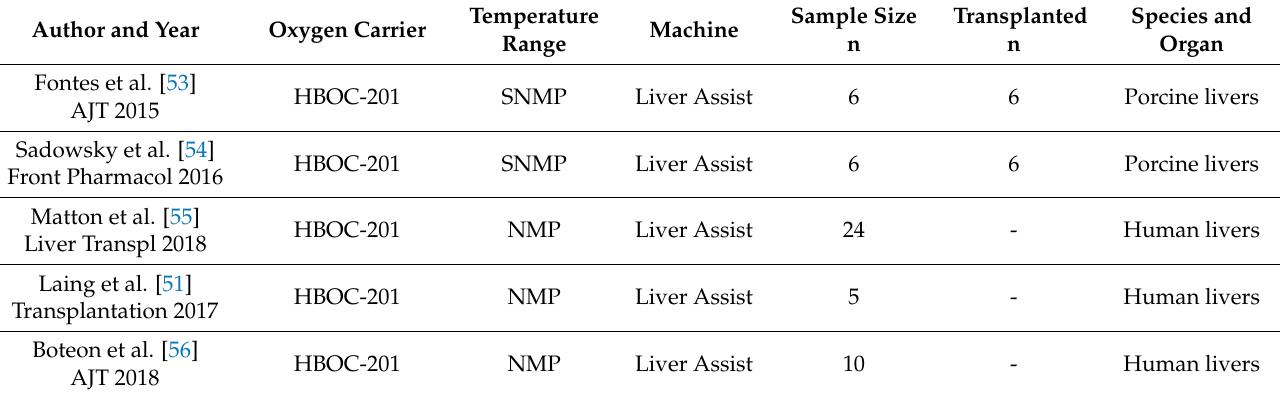
Table 2. Overview of ex situ (sub)normothermic machine perfusion using artificial oxygen